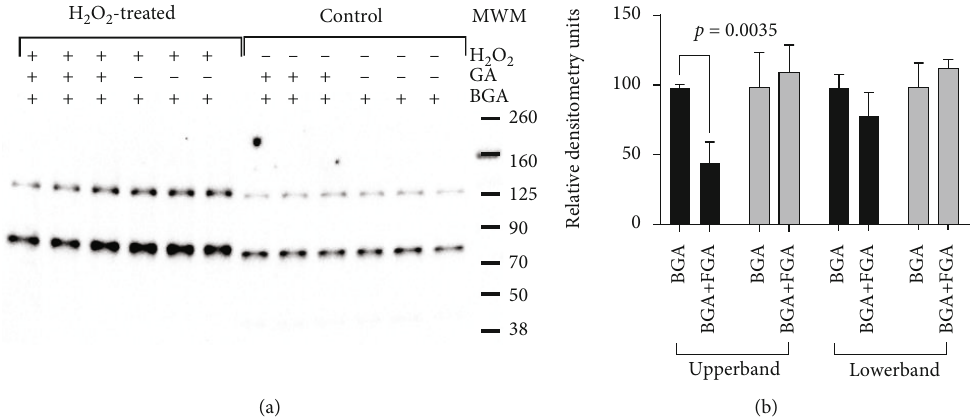
Figure 7: Competition of glucaric acid (GA) with biotinylated glucaric acid (BGA) for binding with nuclear proteins. (a) A representative streptavidin-HRP blot. (b) Densitometry of streptavidin-reactive bands ( n = 3